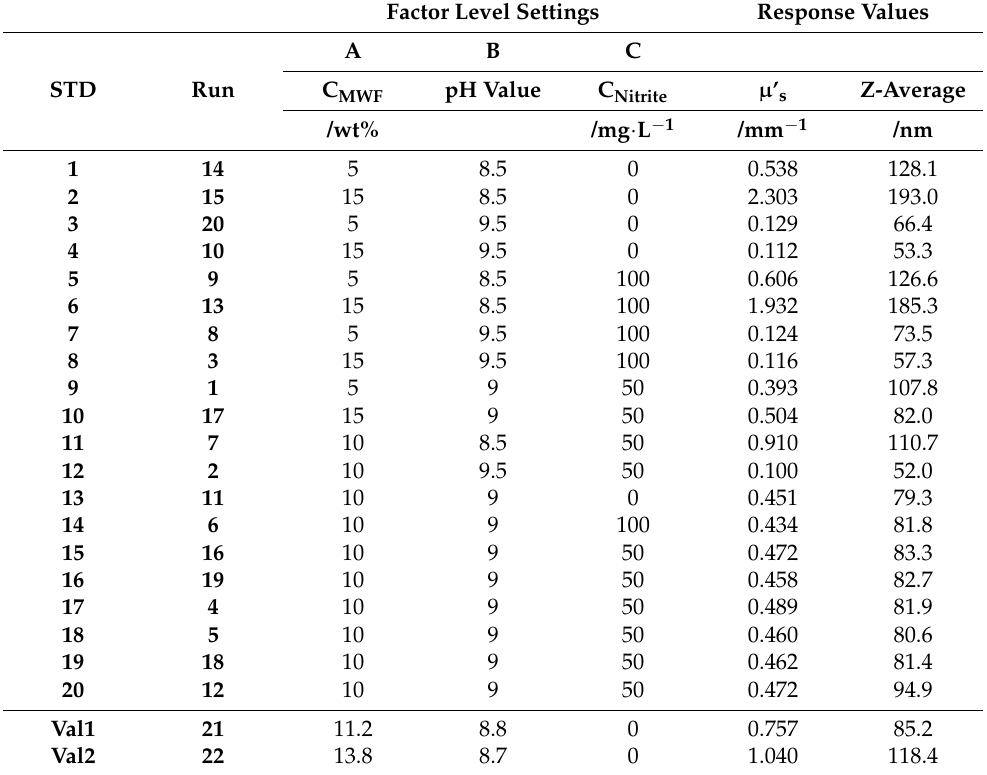
Table 2. Experiments conducted according to the face-centered central composite design (FCD), sorted by standard order (STD) according to the Yates nomenclature. The order in which the measurements were actually performed is also given. The factor level settings of each experimental run are given along with the corresponding response values.